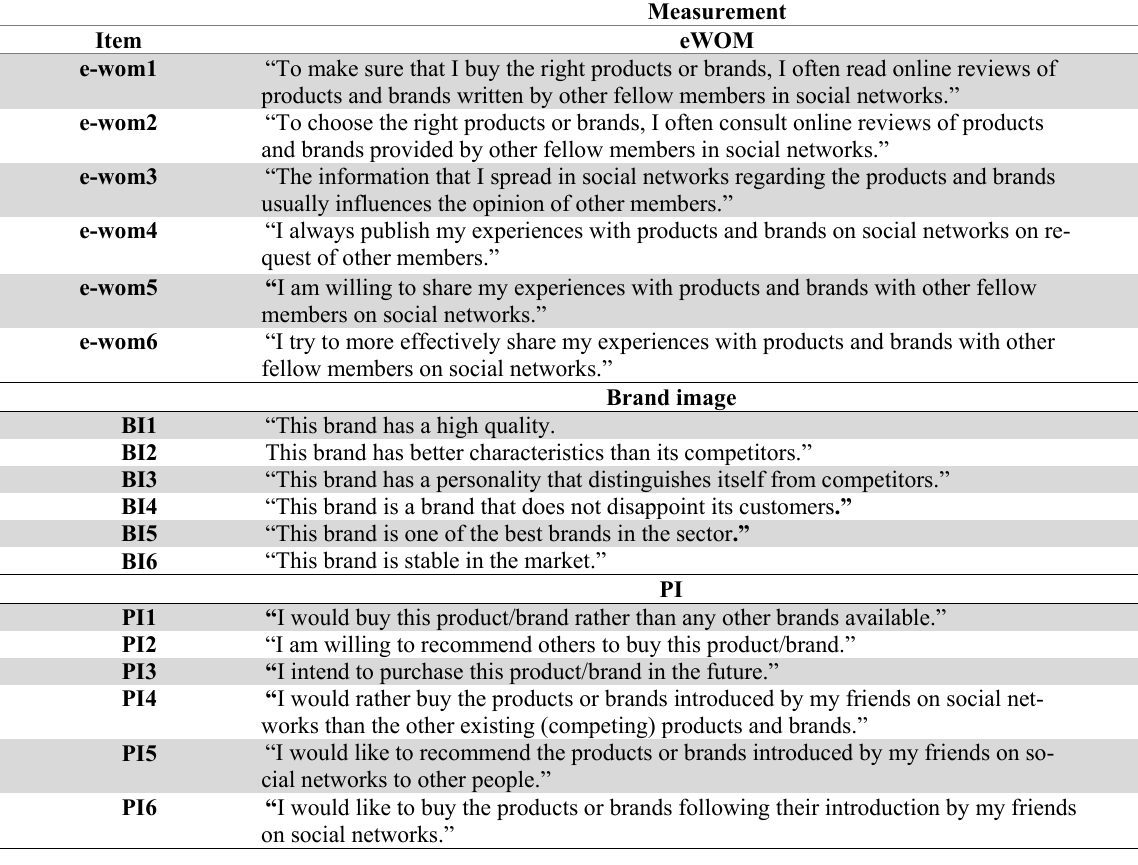
The Measurement of Research